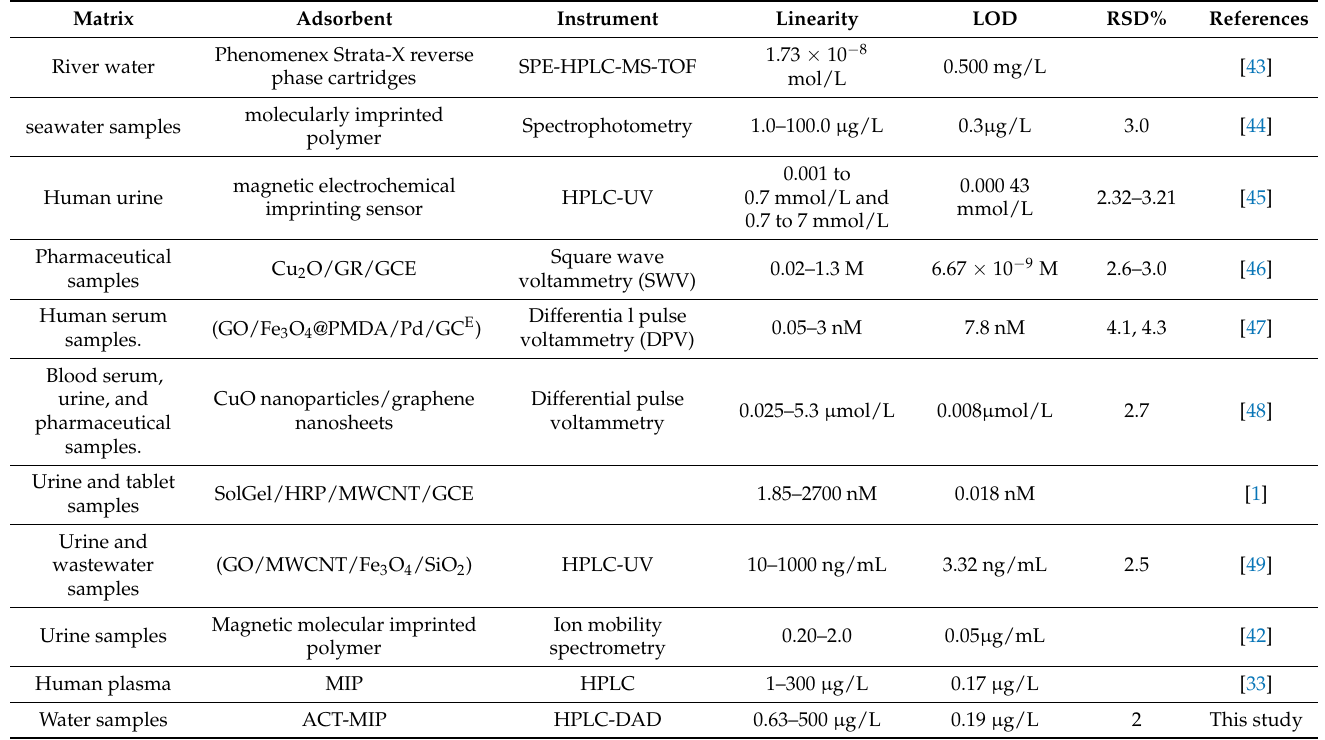
Table 9. Comparison